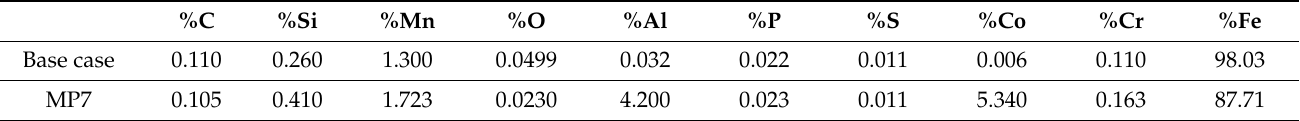
Table 3. Weld metal compositions (mass%).